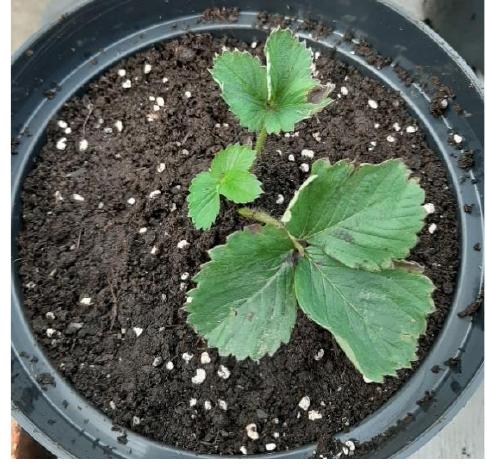
Figure 11. The plantlet of the strawberry cv. Polka.